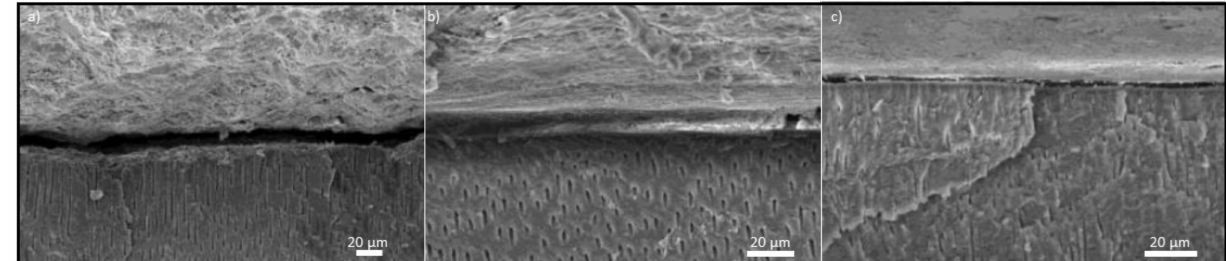
Figure 18. Leaks at the dentine border of the root canal with resilon as cold filling material (SEM): ( a , b ) covered with sealant; ( c ) on the border of the sealant.